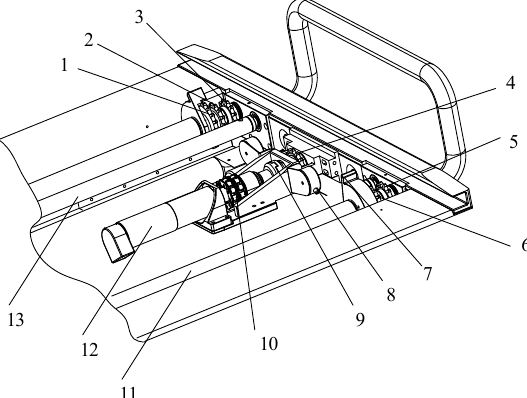
Figure 10. The structural design of the transverse driving part; 1—sprocket 1; 2—sprocket 2; 3— sprocket 3; 4—sprocket 4; 5—sprocket 5; 6—sprocket 6; 7—the sprocket cover; 8—the cable box; 9— the clutch structure; 10—the coupling with the sprocket chain structure; 11—the transverse drive roller; 12—the brushless DC reduction motor; 13—the direction-change roller.